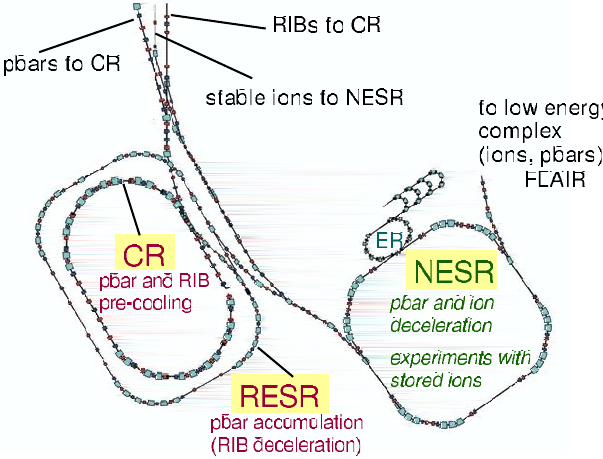
FIG. 1. (Color) The 13 Tm storage rings of the FAIR facility for ions and